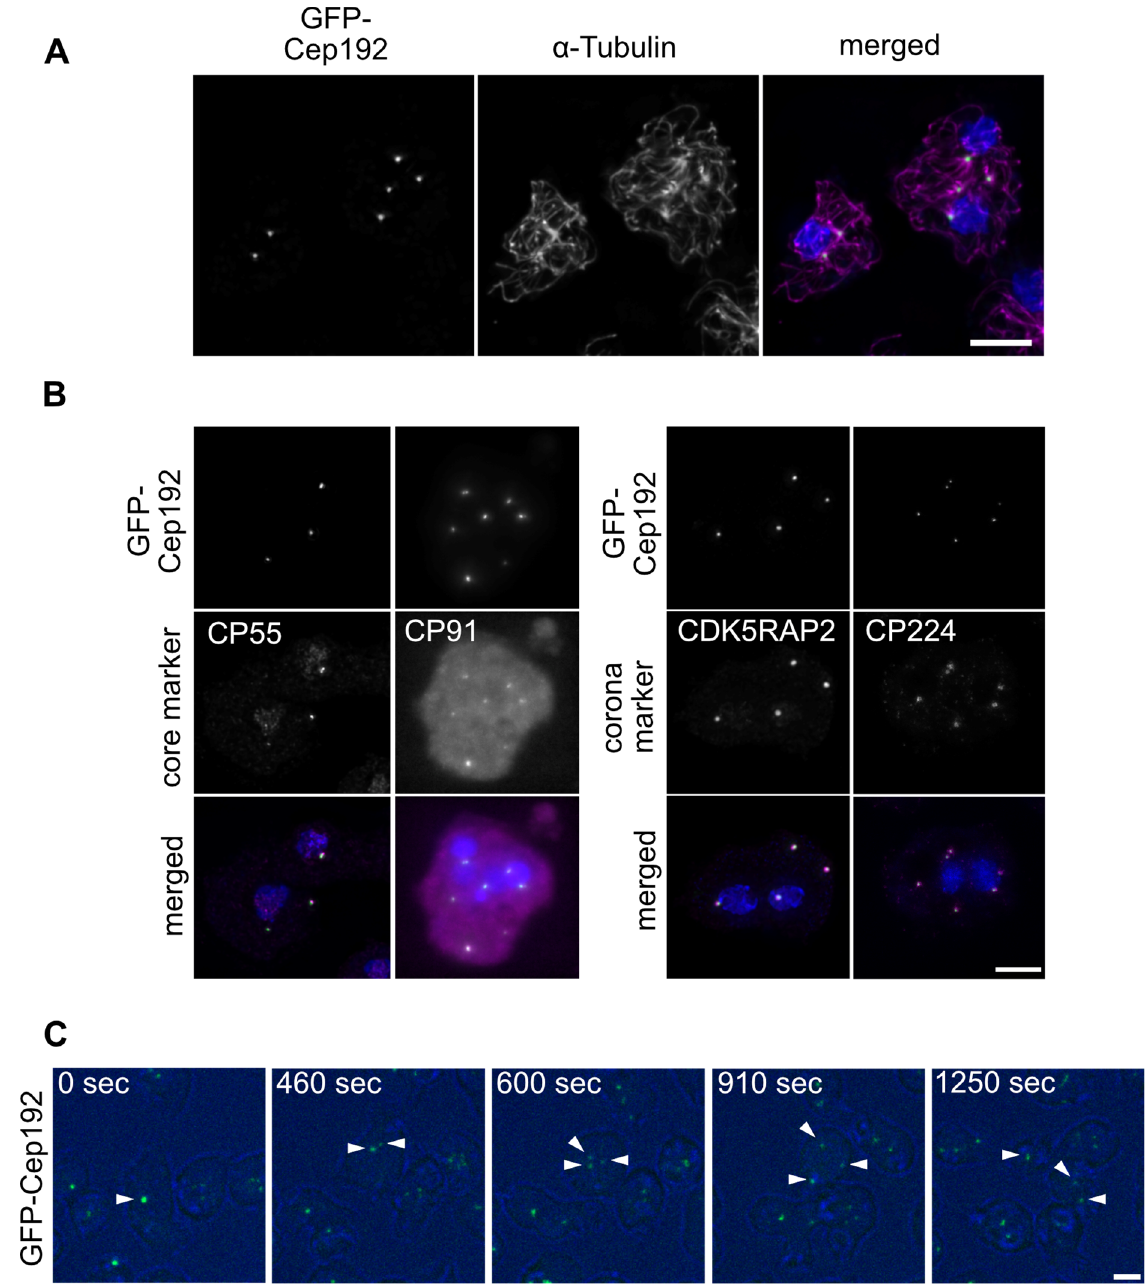
Figure 5. Immunofluorescence microscopy of GFP-Cep192 overexpression elicits supernumerary MTOCs. ( A ) Additional GFP-Cep192 foci co-stained with anti- α -tubulin/anti-rat-AlexaFluor-568 revealing the MTOC property. ( B ) Co-staining of different core and corona marker proteins with indicated antibodies. Secondary antibody was anti-rabbit-Alexa-Fluor568. Cells were fixed with methanol, shown are deconvolved maximum intensity projections. ( C ) Live cell imaging of GFP-Cep192 during mitosis. Selected time points from video S3 are shown. Arrowheads point at emerging GFP-Cep192 foci. Bar = 5 µm.